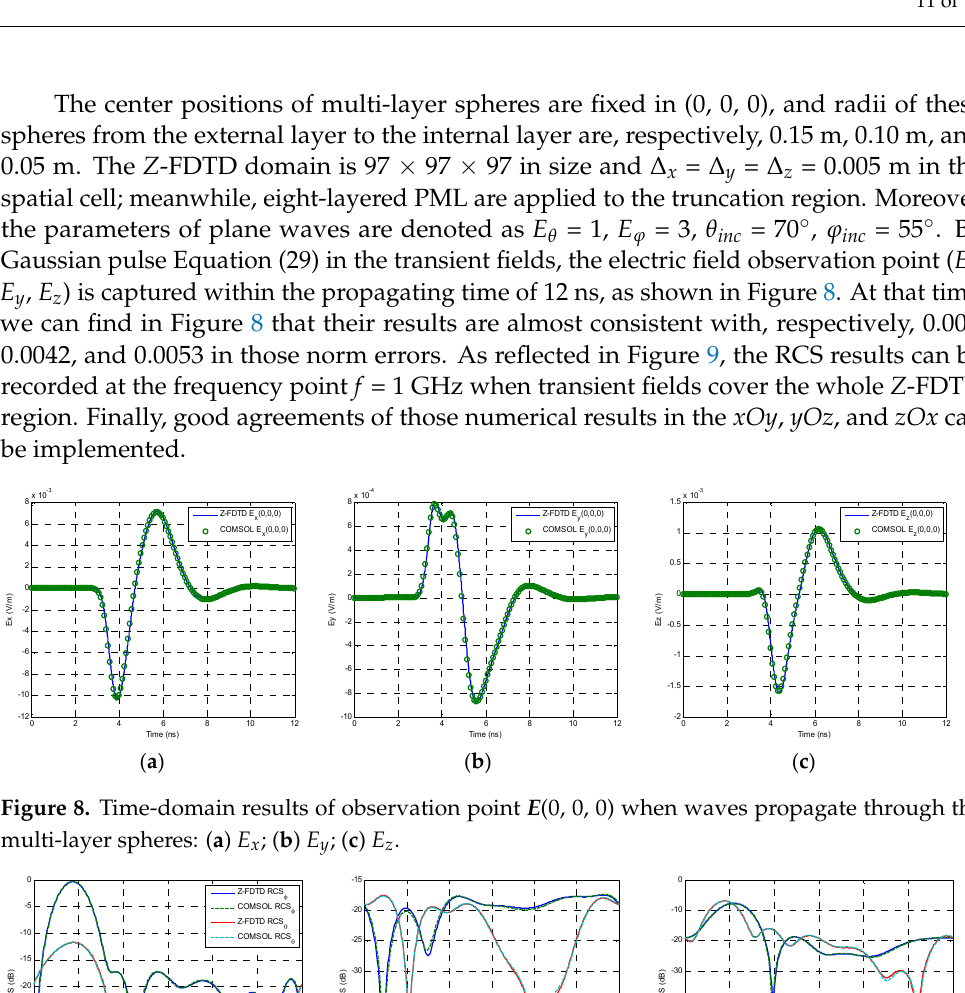
Figure 9. RCS results of multilayer spheres at the frequency point f = 1 GHz: ( a ) xOy plane; ( b ) yOz plane; ( c ) zOx plane.